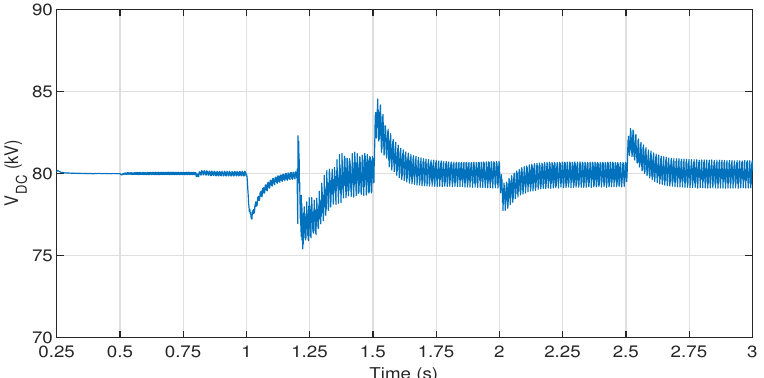
Figure 9. Time response of the voltage across the DC bus. The process of the transmission of active power in the HVDC from one terminal to another is shown in Figure 10, which plots in blue color the injected/absorbed active powers by the four terminals into/from their respective AC grids (if the active power is positive, it is considered that the terminal injects active power into the grid, in